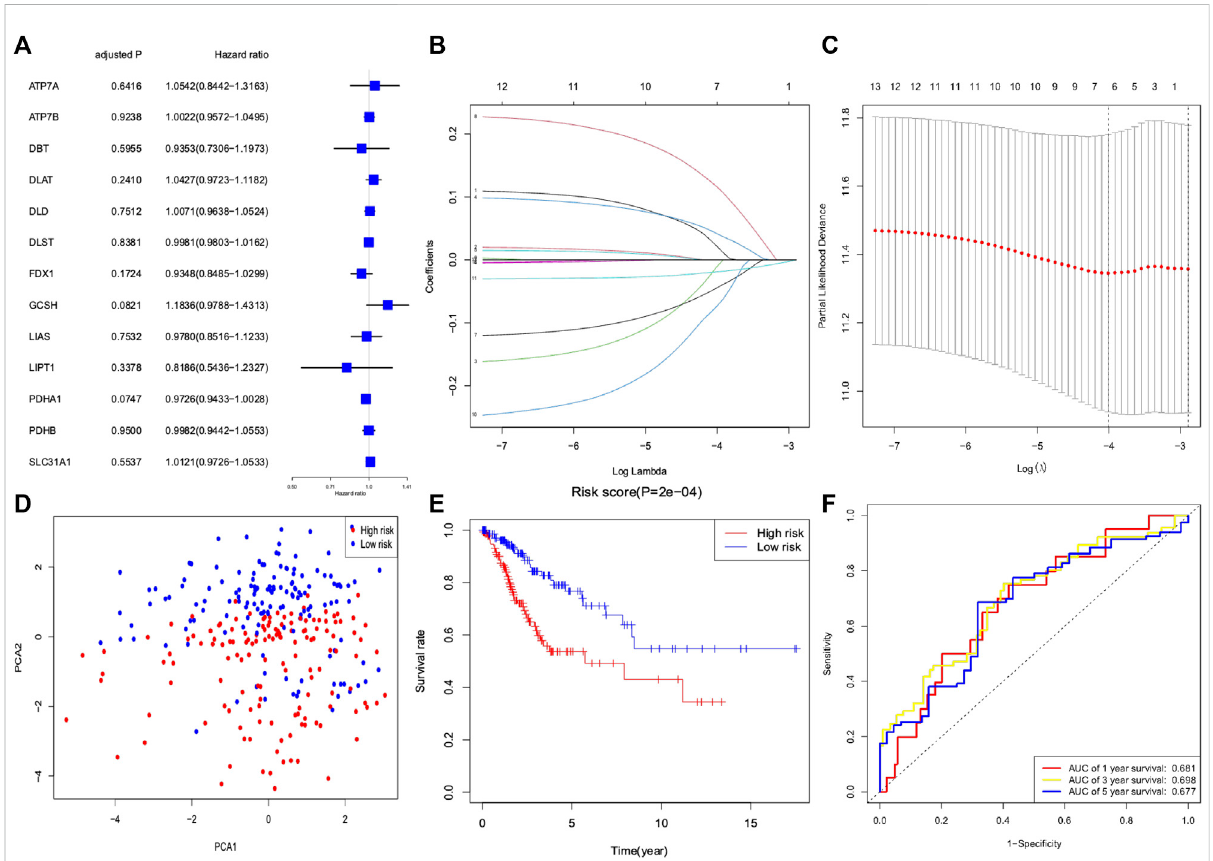
FIGURE 4 Development of arisk signature for cervical cancer patients collected from TCGA database. (A) Univariate Cox regression of cervical cancer for 13 cuproptosis-related genes. (B) LASSO regression of 13 cuproptosis-related genes. (C) Cross-validation in the LASSO regression for optimizing parameter selection. (D) PCA plot for cervical cancer based on the risk score. (E) Kaplan – Meier survival curves for overall survival in the two groups. (F) AUC values of the ROC curve of the risk